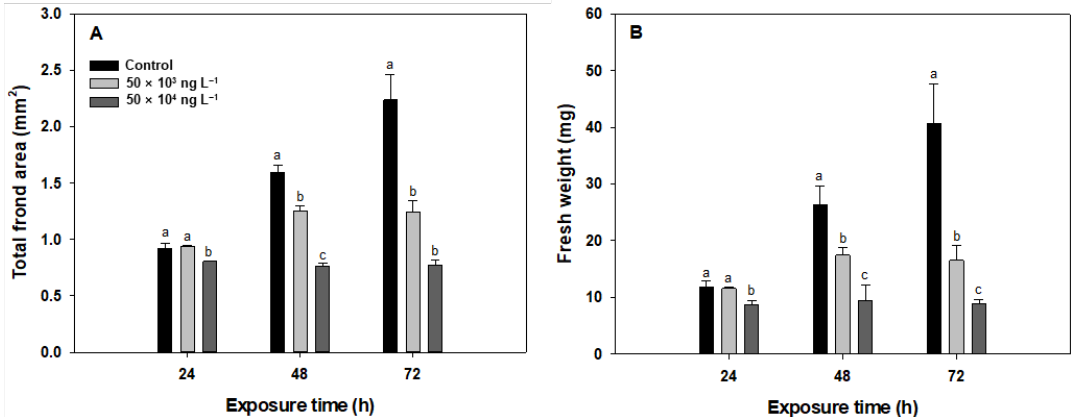
Figure 1. Total frond area ( A ) and fresh weight ( B ) of Lemna minor exposed to diuron (50 × 10 3 and 50 × 10 4 ng L −1 ) for 24, 48, and 72 h. Data represent mean values of three replicates. Standard deviations are indicated by error bars. Different letters indicate statistically significant differences at p < 0.05 (one-way ANOVA, LSD).